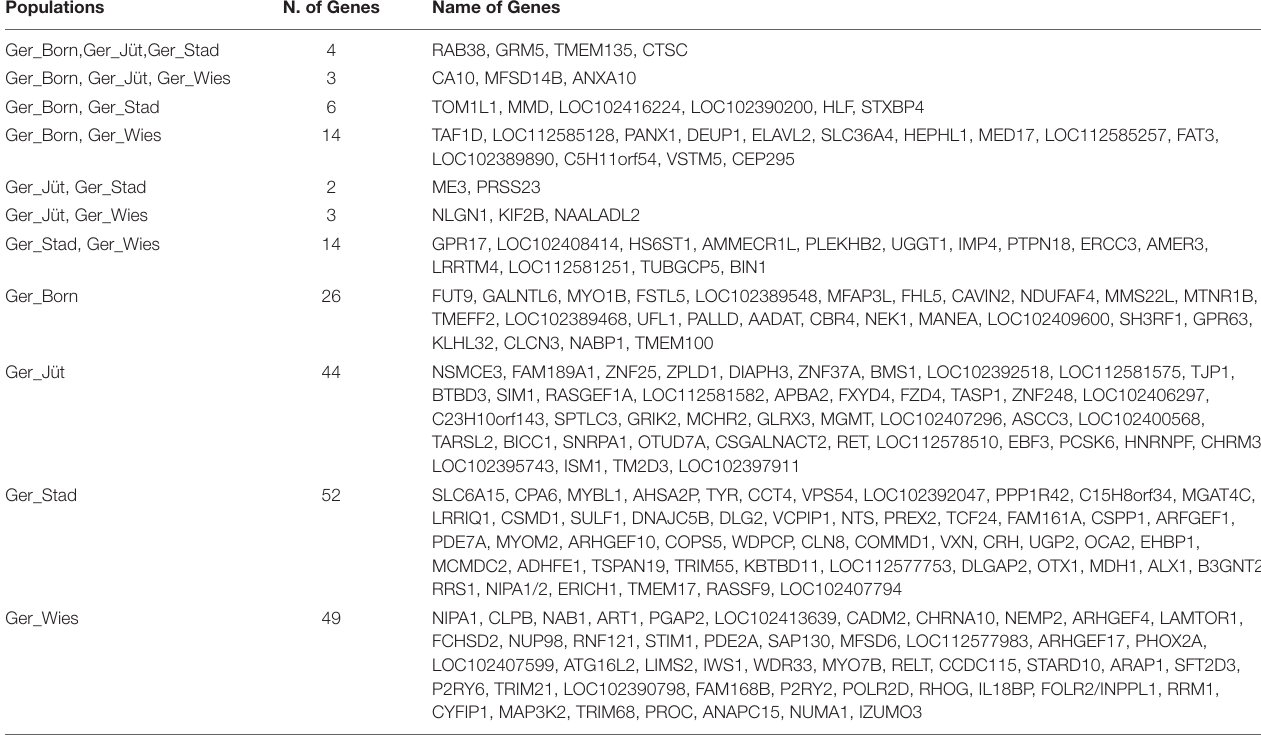
TABLE 6 | Shared and unique genes overlapping ROH regions with the highest frequency SNPs in the German populations. Populations N. of